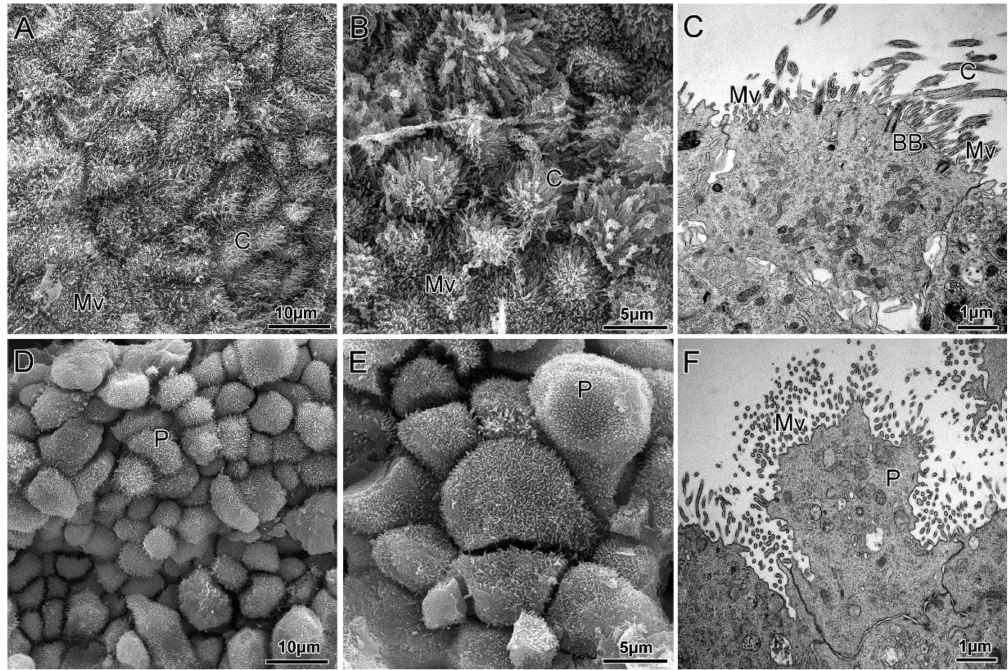
Figure 3. Ultrastructure of the organoid luminal surface showing remarkable changes, the feature of the in vivo endometrium architecture. Representative scanning ( A , B ) and transmission electron micrographs ( C ) of ORG-pp treated with E2 to mimic the proliferative phase, showing numerous microvilli and cilia expansion from the apical surface of epithelial cells. Representative scanning ( D , E ) and transmission electron micrographs ( F ) of ORG-msp treated with E2, P4, cAMP to mimic the mid-secretory phase, showing numerous pinopodes that bulge from the entire luminal cell surface. These large apical cytoplasmic protrusions are characterized by a significant loss of free surface micro-extensions, including cilia and microvilli. C, cilia; Mv, microvilli; BB: basal body; P: